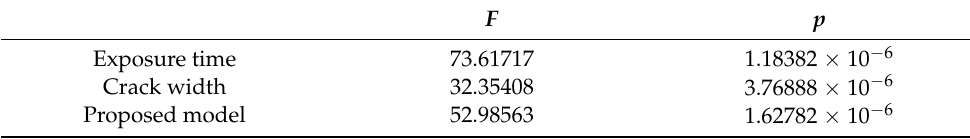
Table 4. F-test results of the proposed model for surface chloride concentration.